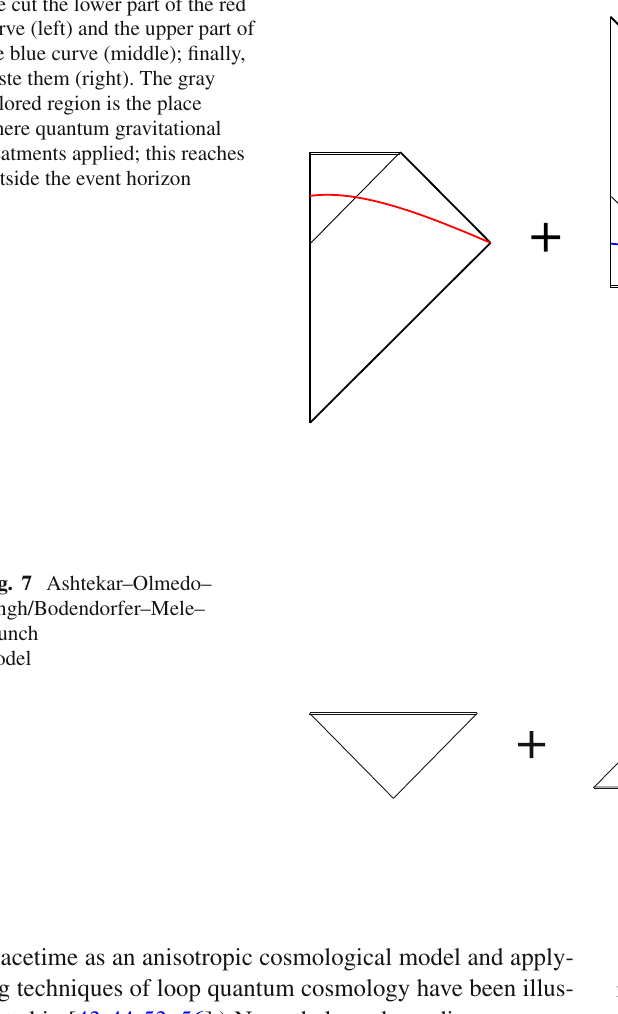
Fig. 6 Haggard–Rovelli model. We cut the lower part of the red curve (left) and the upper part of the blue curve (middle); finally, paste them (right). The gray colored region is the place where quantum gravitational treatments applied; this reaches outside the event horizon